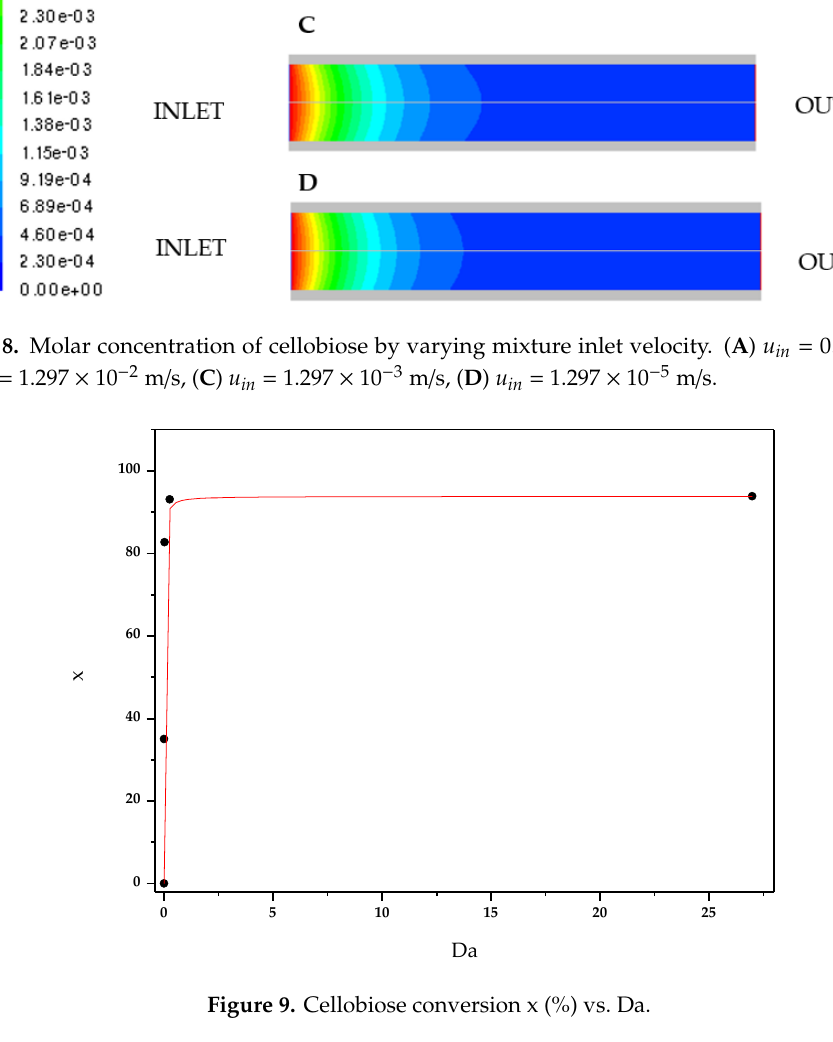
Figure 9. Cellobiose conversion x (%) vs. Da.